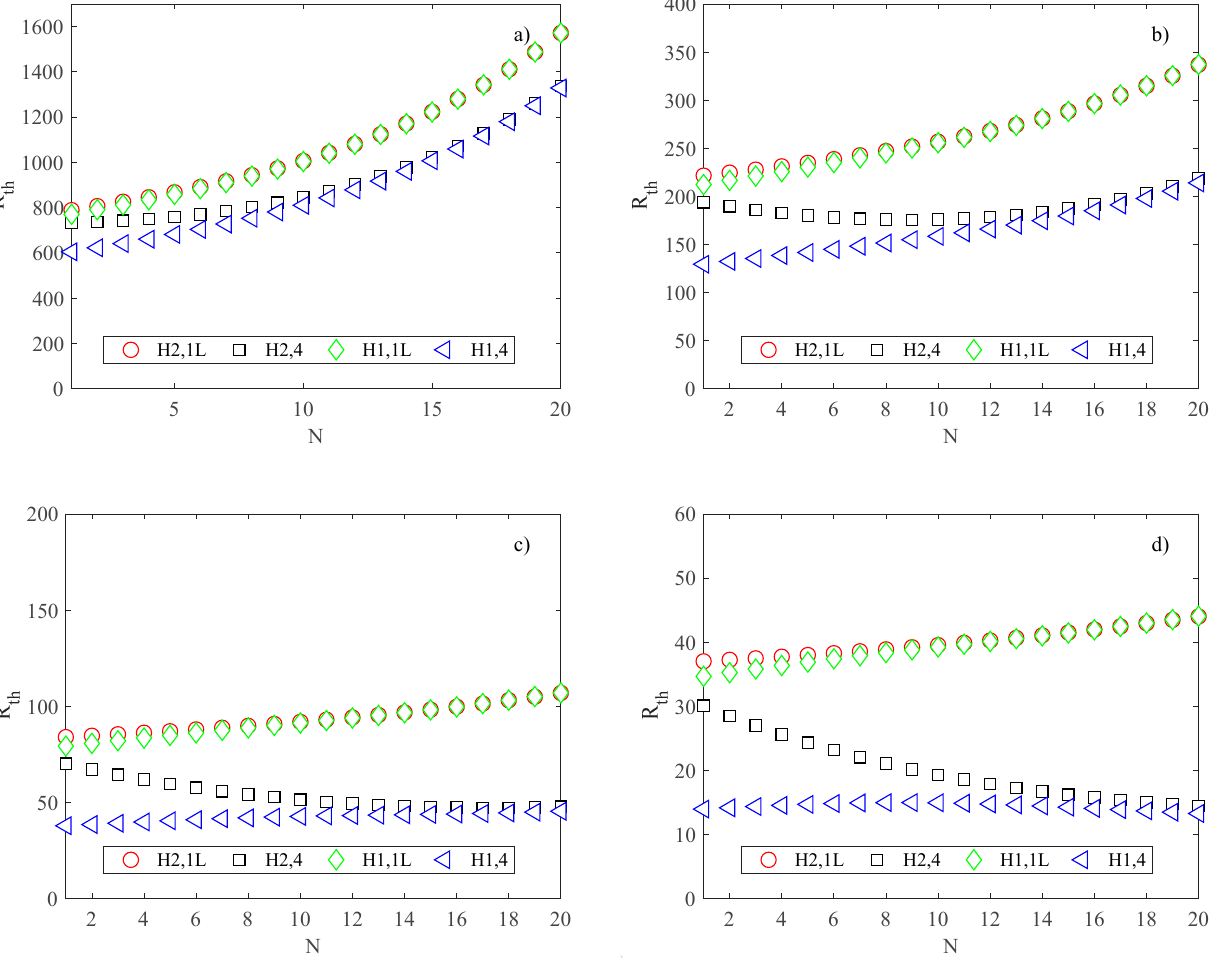
Figure 11. Thermal resistance of the heat sink (K/W); ( a ) B = L = 2.5 mm; ( b ) B = L = 5 mm; ( c ) B = L = 10 mm; ( d ) B = L = 20 mm.